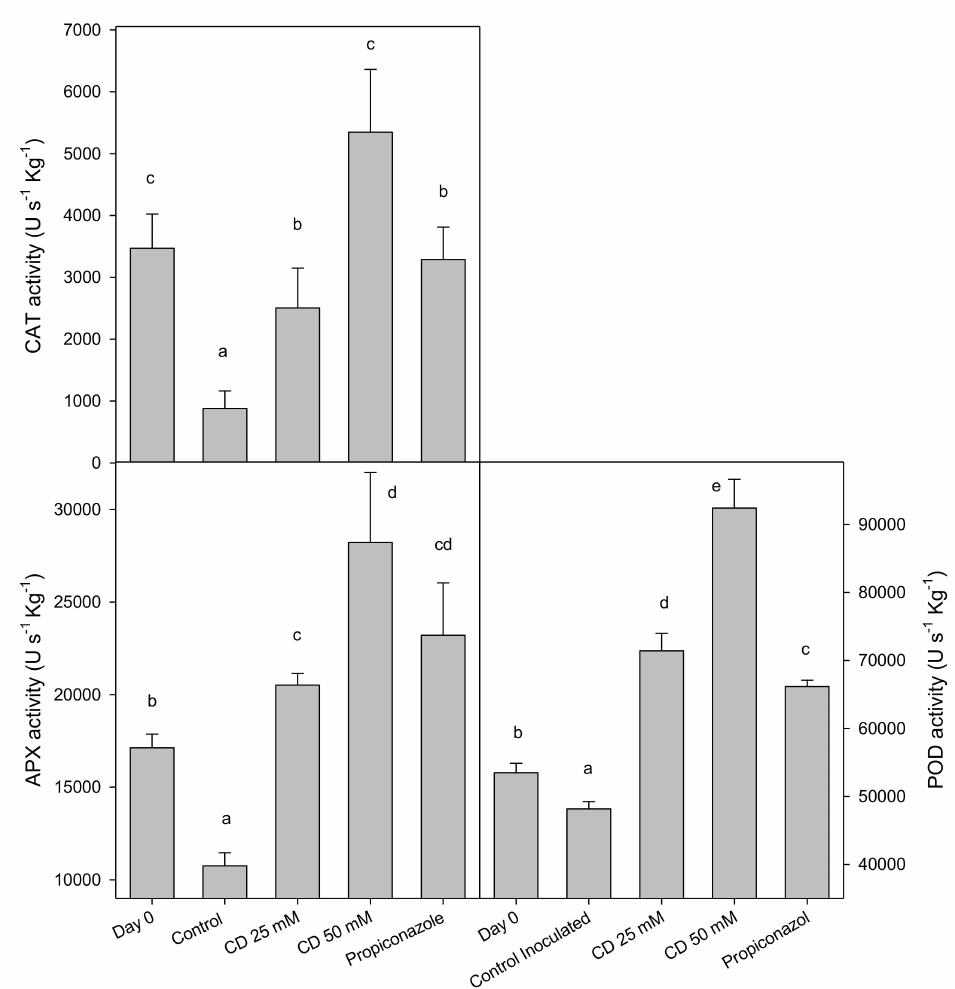
Figure 5. Activity of the antioxidant enzymes catalase (CAT), ascorbate peroxidase (APX) and peroxidase (POD) and, in peel of control and 25 or 50 mM HP- β -CD-thymol and propiconazole treated “Fino 49” lemon fruit at harvest and after 10 d of storage at 20 ◦ C in preventive experiment. Data are the mean ± SE. Di ff erent letters show significant di ff erences ( p < 0.05) among treatments after 10 days of